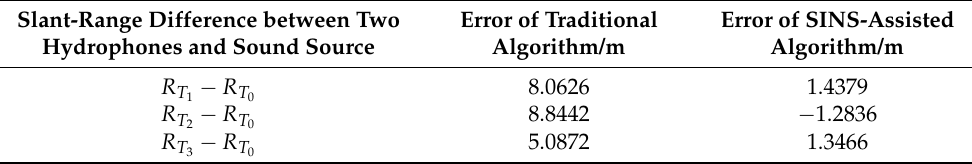
Table 2. Comparison of slant-range difference calculation error.